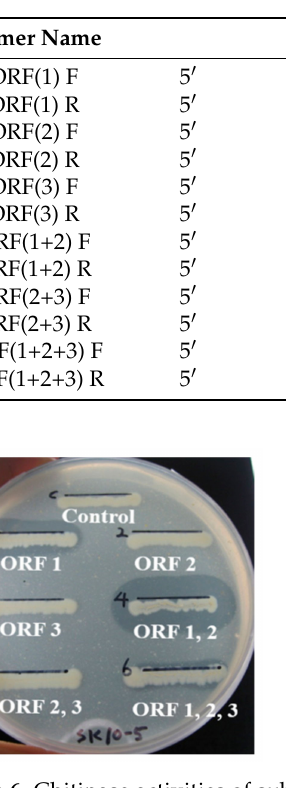
Table 1. Primers for amplification of individual or combinatorial ORFs of the three ORFs of clone SK10-5.